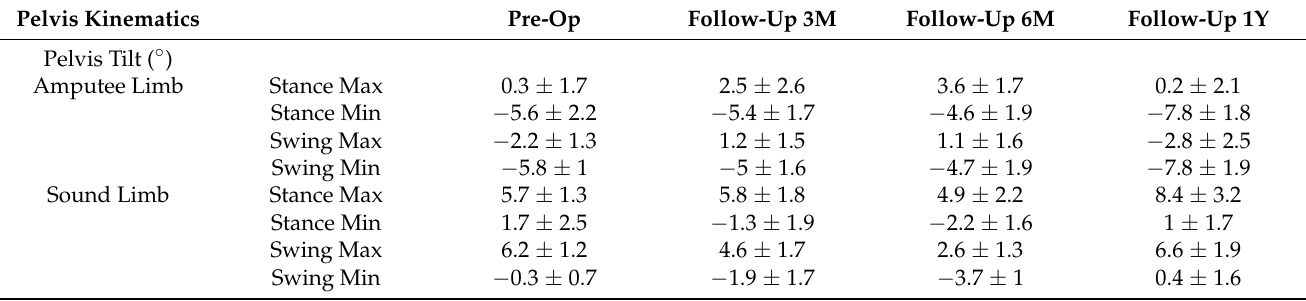
Figure 6. Pelvis joint kinematics over the percentage of gait cycle performed with the amputee limb for the fast gait in sagittal (first row), frontal (second row), and transverse (third row) planes. Descriptive data (first column) are expressed as mean (solid line) and standard deviation (dashed line). The gray line represents pre-operative gait analysis with socket-type prosthesis (ST pre-op), the red line represents gait analysis at 3 months follow-up with osseointegrated prosthesis (OI FU 3M), the blue line represents gait analysis at 6 months follow-up with osseointegrated prosthesis (OI FU 6M), the green line represents gait analysis at 1-year follow-up with osseointegrated prosthesis (OI FU 1Y). The results of the spm1D repeated-measure ANOVA are presented in the second column. Gray areas represent statistically significant differences ( p < 0.05) among the groups. The differences between pre-operative phase and either 3 months follow-up (third column) or 1-year follow-up (fourth column) were assessed through t-test with Bonferroni correction. Table 5. Descriptive peak pelvis kinematics for the amputee and sound limb in the pre-operative gait analysis (socket-type prosthesis, ST) and the follow-up gait analyses (osseointegrated prosthesis, OI). Data are presented for the fast gait as mean ± standard deviation separately for stance and swing